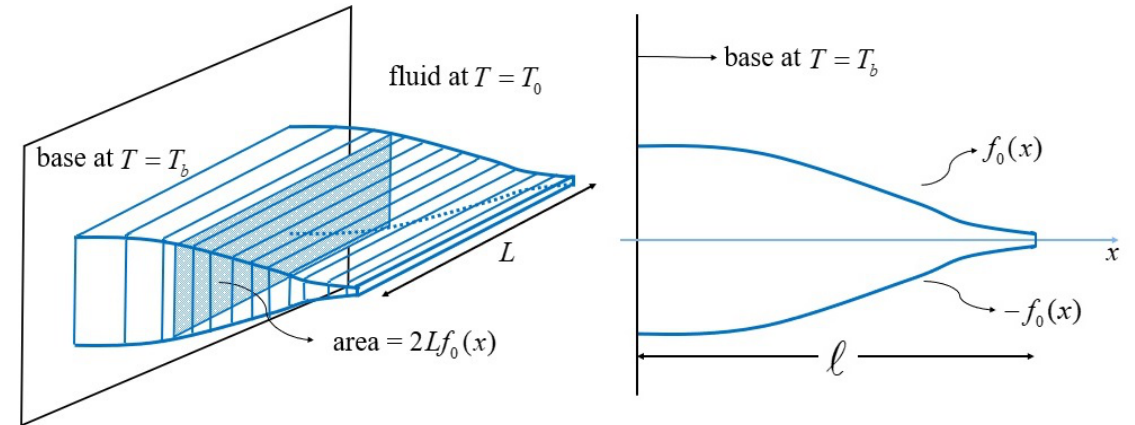
Figure 1. The longitudinal fin: a given profile is shown, described by a suitable f 0 ( x ) together with the coordinate system, the cross-sectional area, and the geometrical